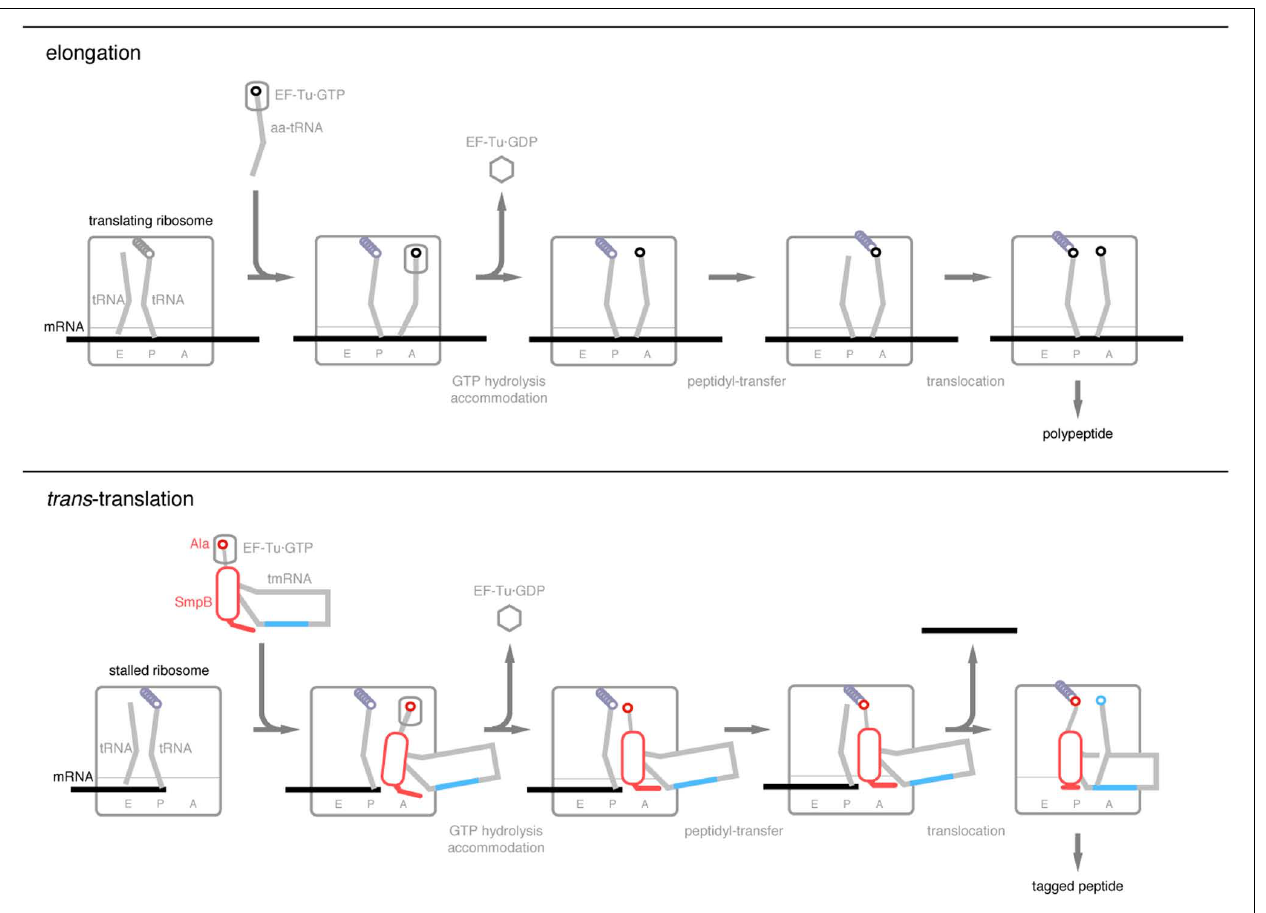
the C-terminal tail undergoes a drastic conformational change from the extended to the folded structures to accommodate the resume codon of tmRNA into the decoding center. During these processes, TLD and the globular domain of SmpB mimic the upper and lower halves of tRNA,